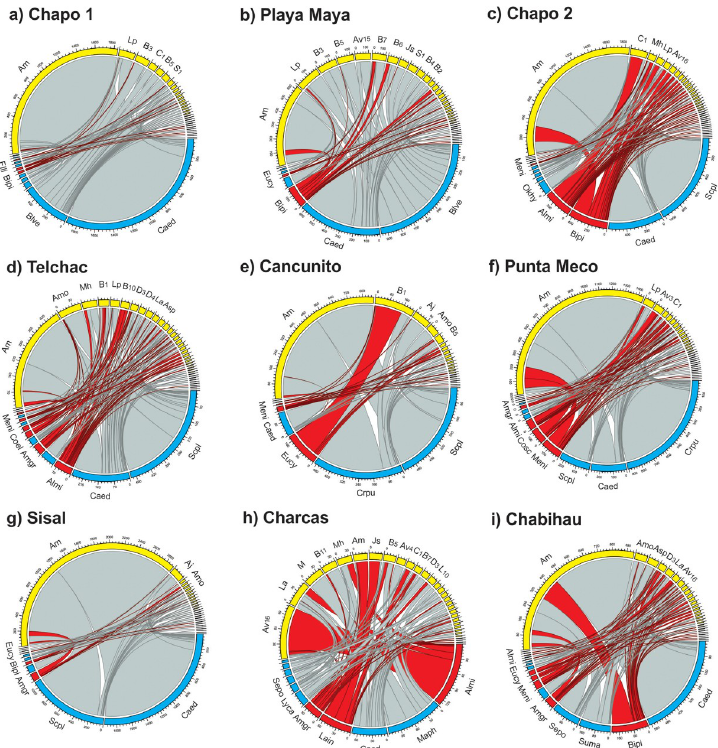
TS1 and TS2 for a complete list of plant and floral visitors and their codes). Numbers represent a scale for the number of interactions for a particular plant or floral visitor. Only codes for floral visitors with more than 100 visits are shown. Gray lines represent interactions between native plants and floral visitors, and red lines between alien plant species and floral visitors. Sites are ordered in increasing proportion of alien flower abundance (see Table 1).